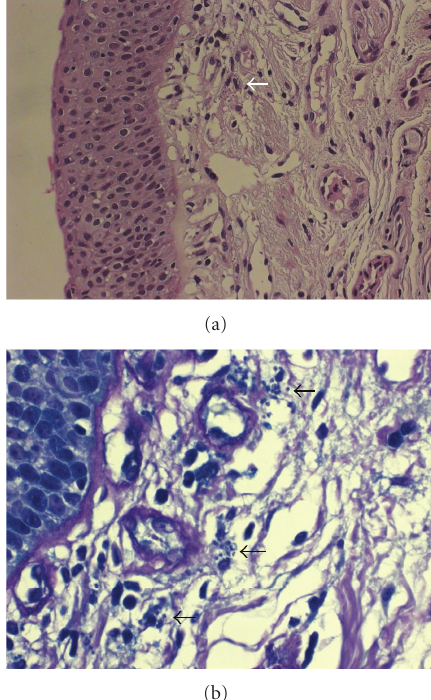
Figure 2: (a) Bronchial biopsy showing epithelial hyperplasia and few Leishmania amastigotes within subepithelial histiocytes (white arrowhead). (Hematoxylin-Eosin × 200). (b) A higher magnifica- tion view of the positive area. Several collections of Leishmania amastigotes are indicated by black arrowheads (Giemsa × 1000).